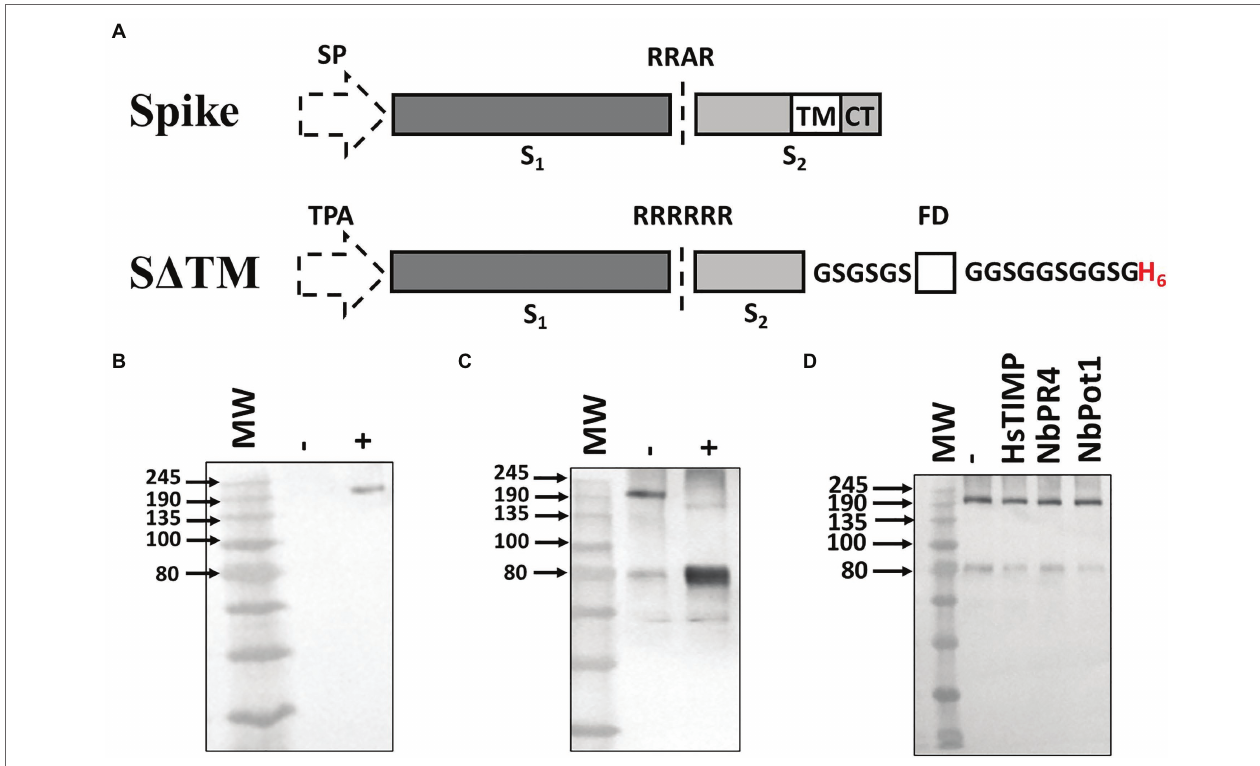
FIGURE 1 | Design and expression optimization of SARS-CoV-2 S ∆ TM in N. benthamiana. (A) Schematic of the synthetic gene sequence encoding the S ∆ TM antigen and the parental (wildtype) sequence from which it was derived (Spike). The native signal peptide (SP) was replaced with a heterologous leader sequence from tissue plasminogen activator (TPA). The furin cleavage sequence (RRAR) was replaced with a hexa-arginine motif (RRRRRR) to enhance processing. A GCN4 fibritin trimerization foldon domain (FD) and a His tag (H 6 ) were included at the C-terminus following GSGSGS and GGSGGSGGSG linkers, respectively. The locations of transmembrane region (TM), cytoplasmic tail (CT), and S 1 and S 2 domains of the spike are indicated. (B) Western blot showing expression of S ∆ TM alone ( − ) and with human calreticulin, CRT (+). (C) Western blot demonstrating co-expression of S ∆ TM with CRT and human furin to demonstrate integration of expression approaches. A control where the glycoprotein was co-expressed with CRT but not furin ( − ) was included alongside the experimental sample (+). (D) Western blot demonstrating co-expression of S ∆ TM with broad-spectrum protease inhibitors HsTIMP, NbPR4, and Nbpot1. In each case, the antigen was co- expressed with CRT and the protease inhibitor of interest. A negative control was included where the glycoprotein was co-expressed with CRT only ( − ). MW, molecular weight